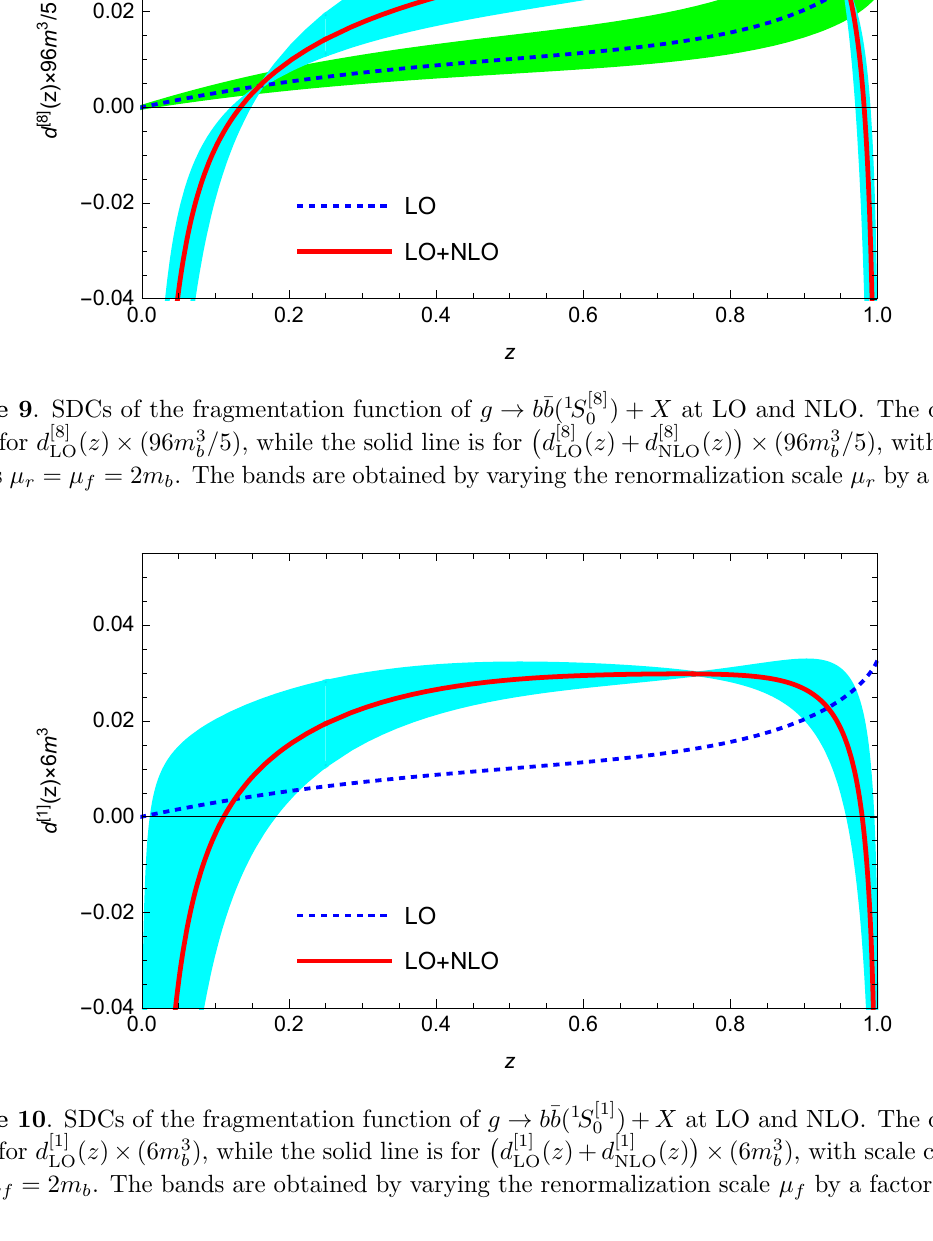
The sensitivities of LO and LO+NLO FFs with respect to the factorization scale (cid:22) are illustrated in (cid:12)gure 10 for g ! Q (cid:22) Q ( 1 S [1] ) + X and (cid:12)gure 11 for g ! Q (cid:22) Q ( 1 S [8] 0 with (cid:22) = 2 m and (cid:22) varying from m to 4 m . Note that the (cid:22) r b f b b be thought as theoretical uncertainties, because FFs are always de(cid:12)ned at a speci(cid:12)c value of (cid:22) f